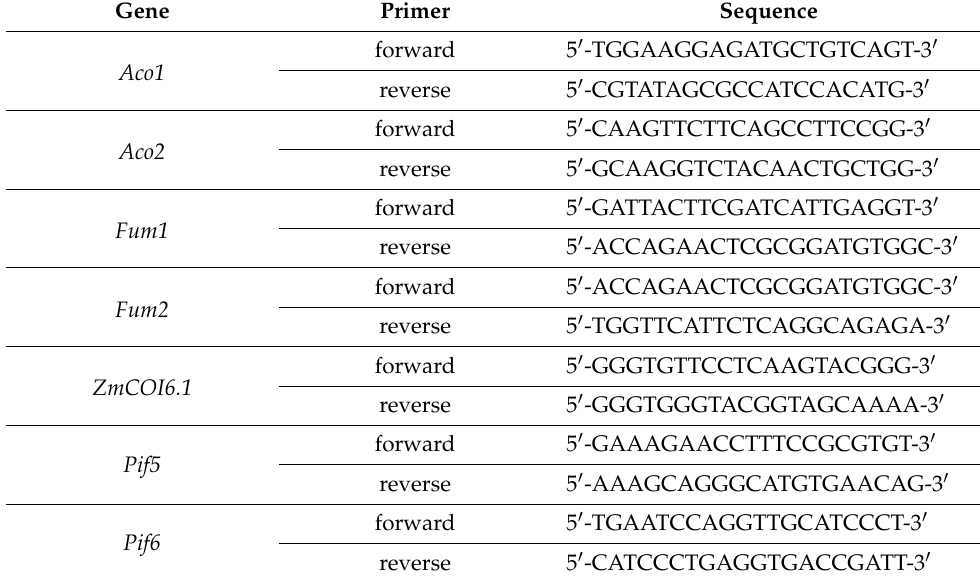
Table 1. Oligonucleotides for